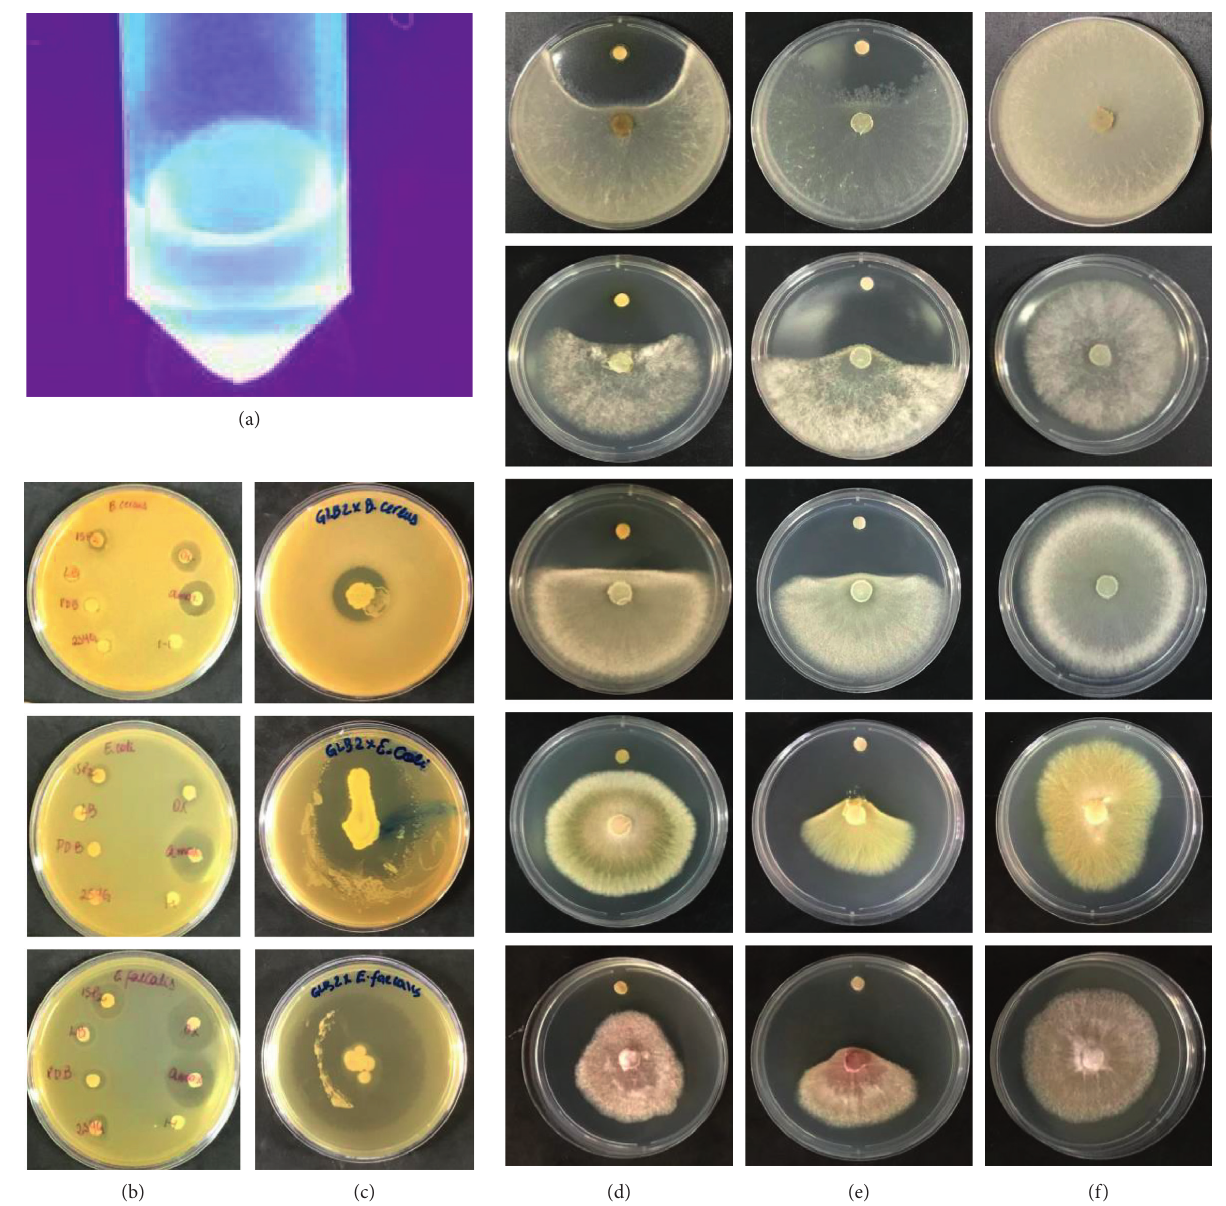
Figure 3: Antimicrobial activity of NPE (a) produced by B. cepacia COPS. Columns (b) and (c) correspond to different crude extracts’ antibacterial activity compared to overlay assay (top to bottom: Bacillus cereus , Escherichia coli, and Enterococcus faecalis ). Lanes (d) COPS NPE, (e) benomyl, as positive control, and (f) negative control represent the antifungal effect. From top to bottom: Moniliophthora perniciosa, Ceratocystis paradoxa , Sclerotinia sclerotiorum , Alternaria alternata , and Fusarium